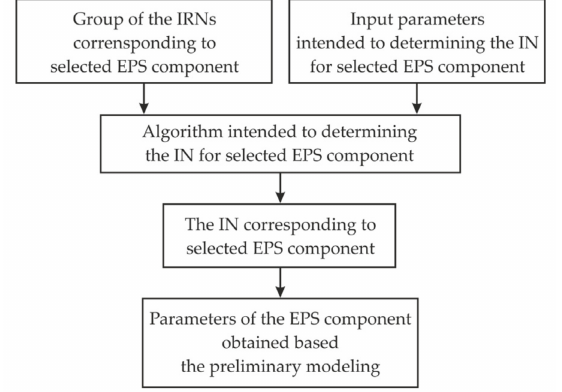
Figure 3. Block diagram of the procedure for the preliminary modeling of EPS